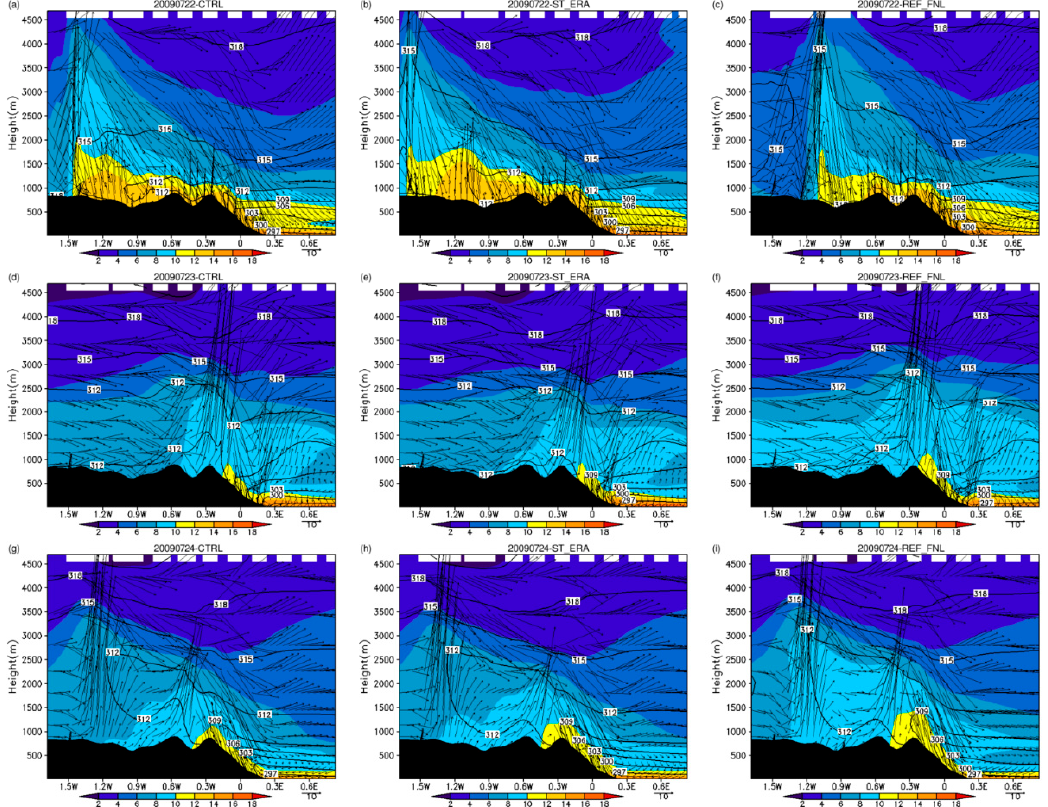
Figure 14. ( a – i ) Same as Figure 12, but at 15 UTC.